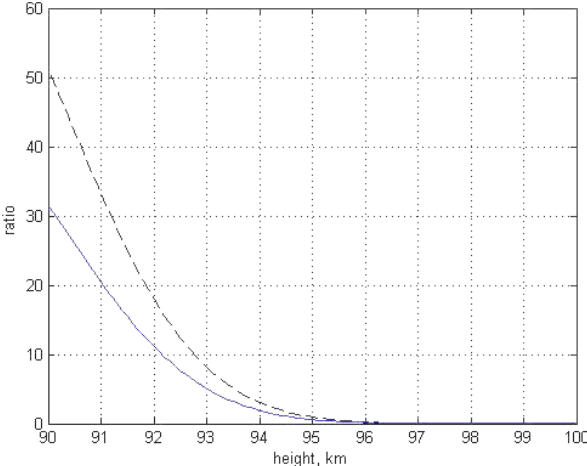
Fig. 7b. Ratio of the eddy diffusion and molecular diffusion coeffi- cients (dashed curve) and the ratio of eddy heat conductivity to the thermal conductivity (solid curve) calculated with the eddy diffu- sion coefficient given by L97 for polar summer.